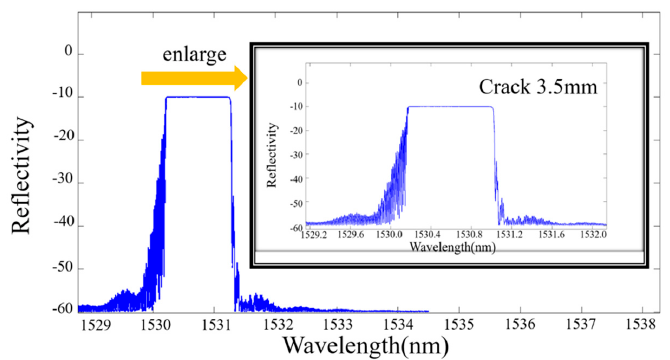
Figure 16. The simulated reflection intensity of a crack with a length of 3.5 mm.